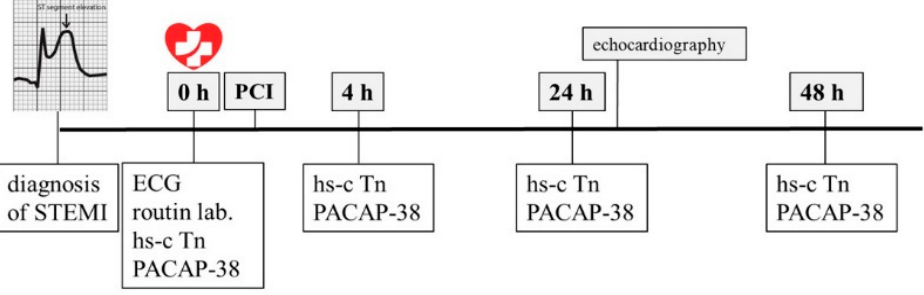
Figure 9. Human study protocol. STEMI: ST-elevation myocardial infarction, ECG: electrocardiography, lab.: laboratory examinations, hs-cTn: hypersensitive cardiac troponin .